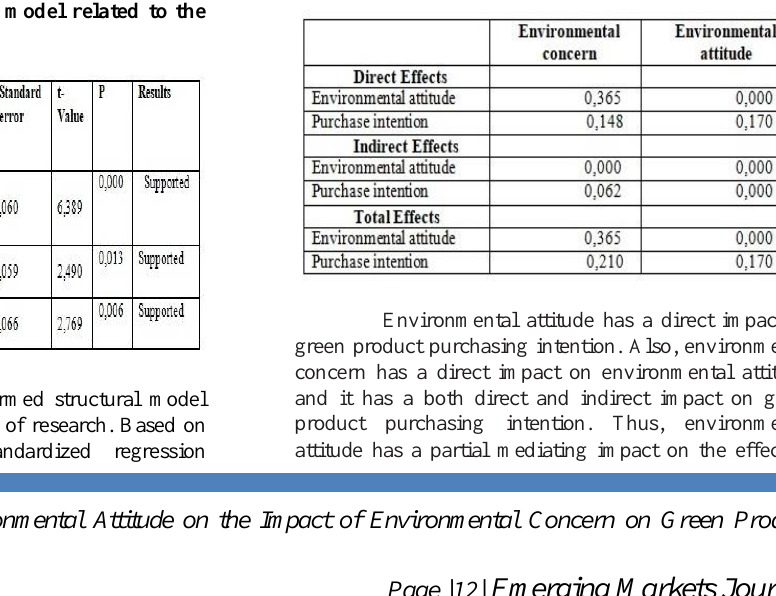
Table 7. Total, Direct and Indirect